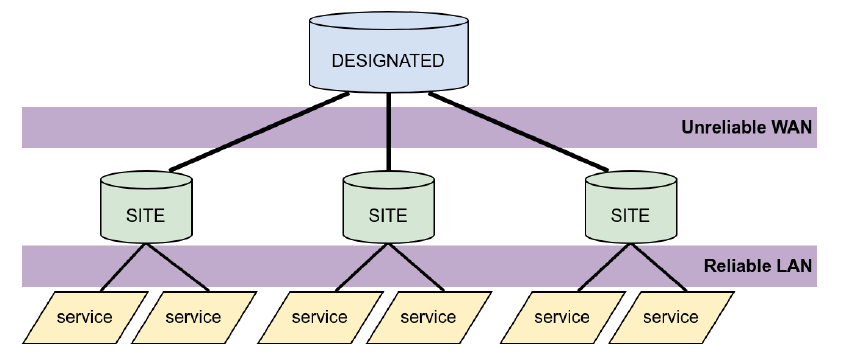
Figure 2. WAVEMQ: A tiered publish-subscribe message bus